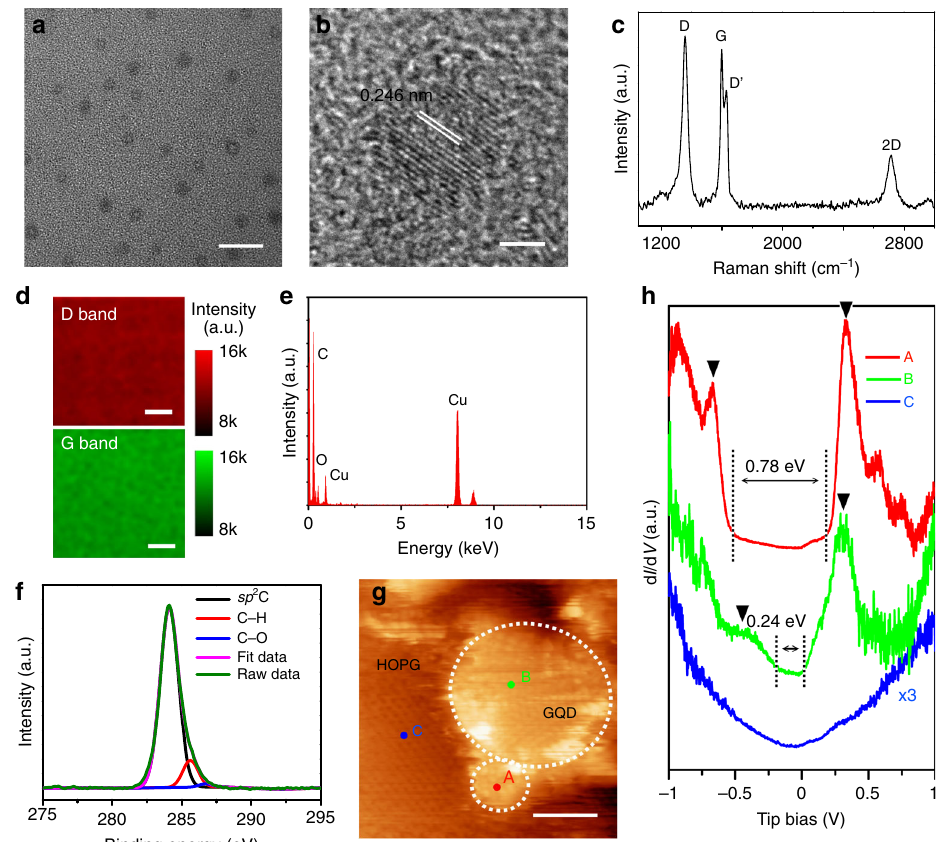
Fig. 2 Characterization of the P-GQDs. a High-resolution transmission electron microscope (HRTEM) image and b an enlarged image and c Raman spectrum of the graphene quantum dots produced by PECVD (P-GQDs). d Raman mapping of the integrated intensity of the D band and the G band of a P- GQD sample. e X-ray energy dispersive spectrometer (EDS) spectrum, f X-ray photoelectron spectroscopy (XPS) C1s spectrum of the P-GQDs. g Scanning tunnelling microscopy (STM) image and h scanning tunnelling spectroscopy (STS) spectra of P-GQDs grown on highly oriented pyrolytic graphite (HOPG). The d I /d V curves are collected from the points indicated by colored dots in g . The arrows in h indicate the positions of Van Hove singularities (VHS). The scale bars are 20 nm in a , 2 nm in b , 10 μ m in d and 2 nm in